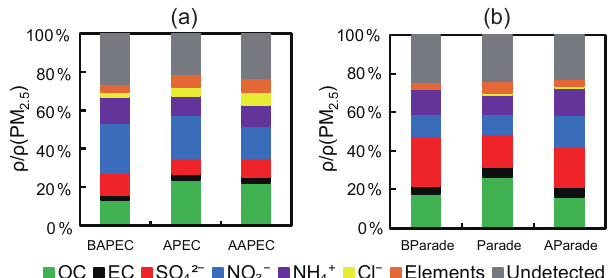
Figure 2. Proportions of the measured components in PM 2 . 5 during (a) APEC 2014 and (b) Victory Parade 2015 campaigns, including organic carbon (OC), elemental carbon (EC), SO 2 − Cl − , and elements. BAPEC and BParade: before APEC and before Victory Parade; AAPEC and AParade: after APEC and after Victory